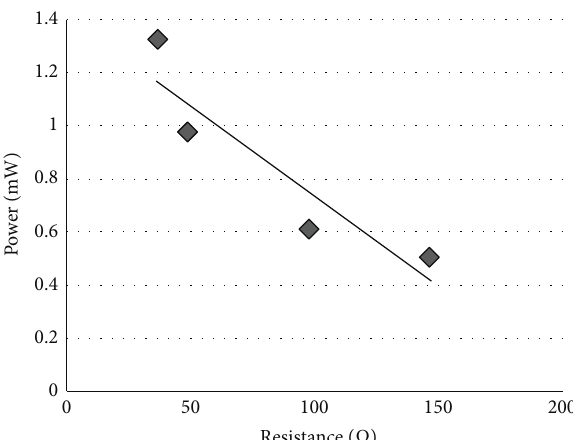
Figure 4: Peak power consumption of the digital processing block using SPONGENT-160.